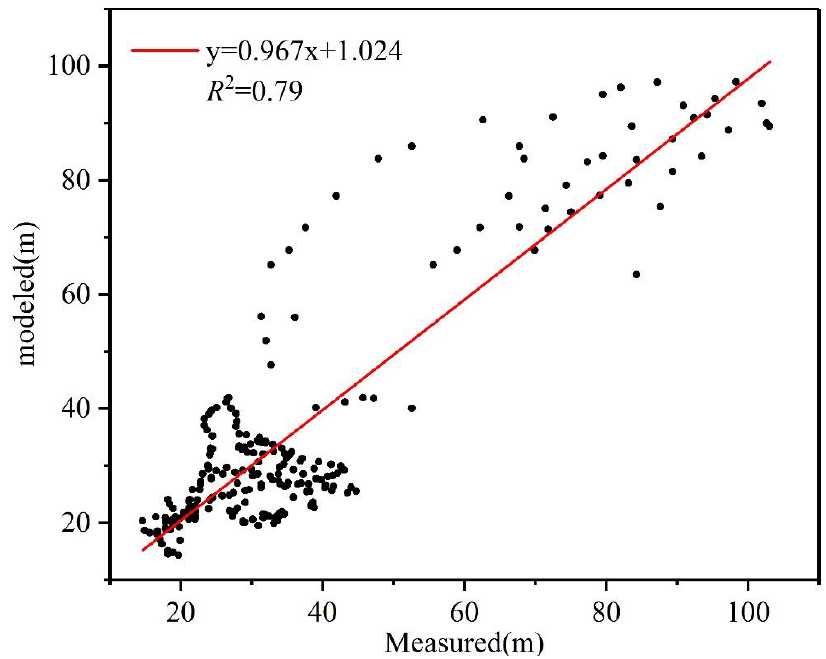
Figure 7. Comparison between the estimated and in situ measured ice thickness of the central axis of the Qingbingtan glacier No. 72.